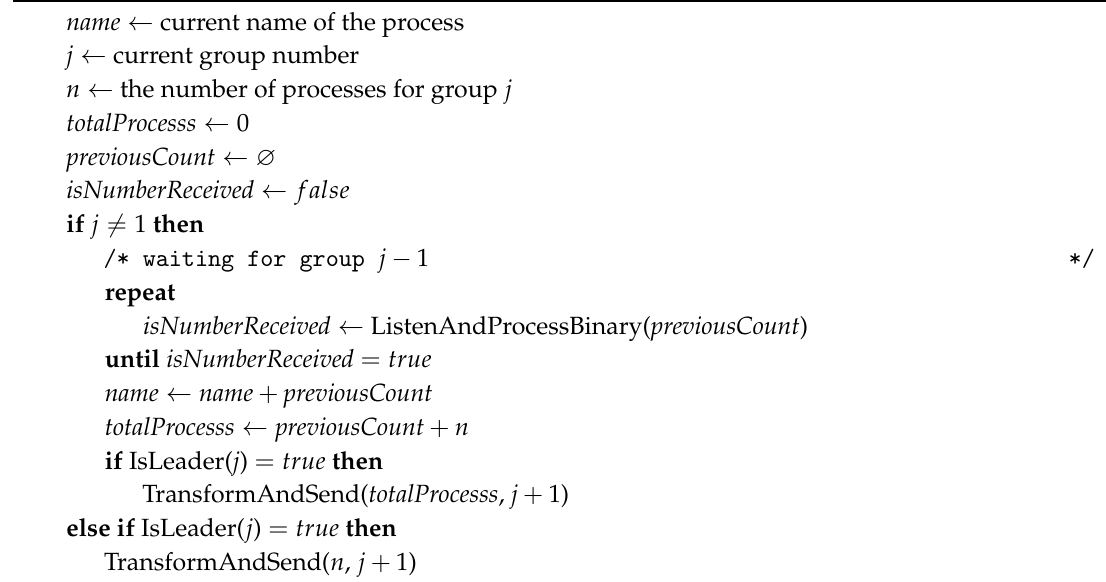
Algorithm 4: M ULTI G ROUP R